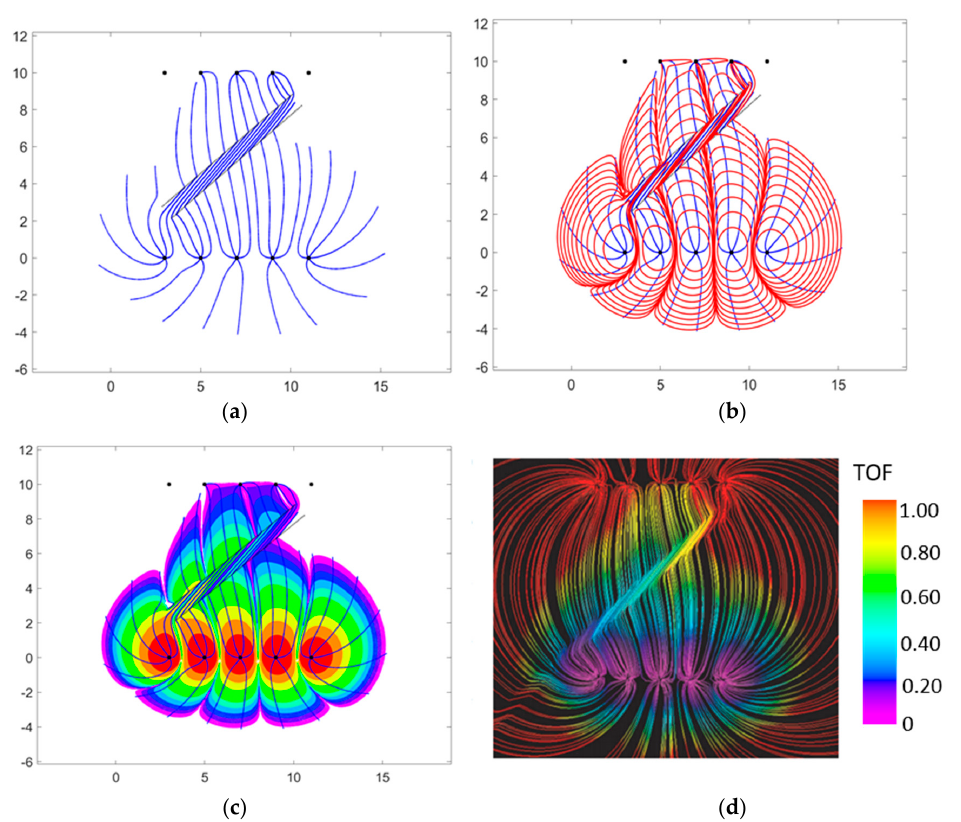
Figure 8. Refraction of flow paths in oblique high permeability fracture zone between a array of 5 injectors (at y = 0) and 5 producers (at y = 10). The permeability of the fracture zone is 10 times that of the ambient reservoir space. Grid-less CAM simulations (run time 5200 s and time step 0.01 s) show: ( a ) only streamlines, ( b ) streamlines with non-dimensional time of flight contours (12 TOFC, red) for advancing waterflood, and ( b ) same as ( b ) but now marked with rainbow color-coded TOFC. ( d ) Grid-based Eclipse simulation confirms the accuracy of CAM flow simulations and time of flight contours. ( a – c ): This study; ( d ): Reproduced with permission from [31].